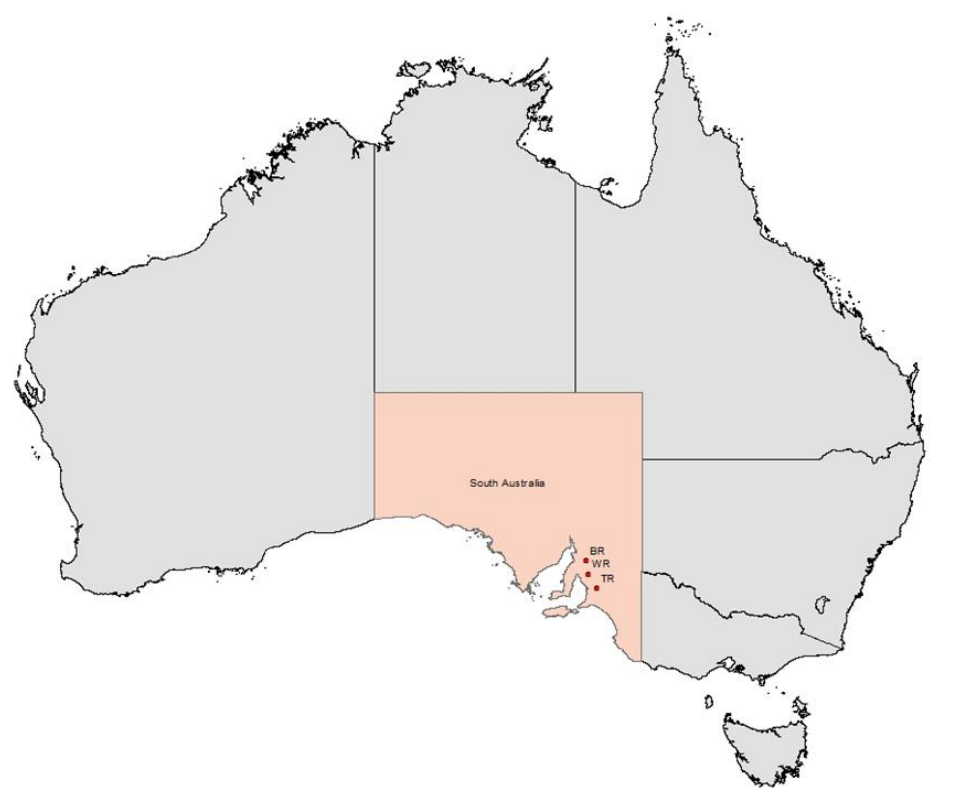
Figure 1. Location of Broughton River (BR), Torrance River (TR), and Wakefield River